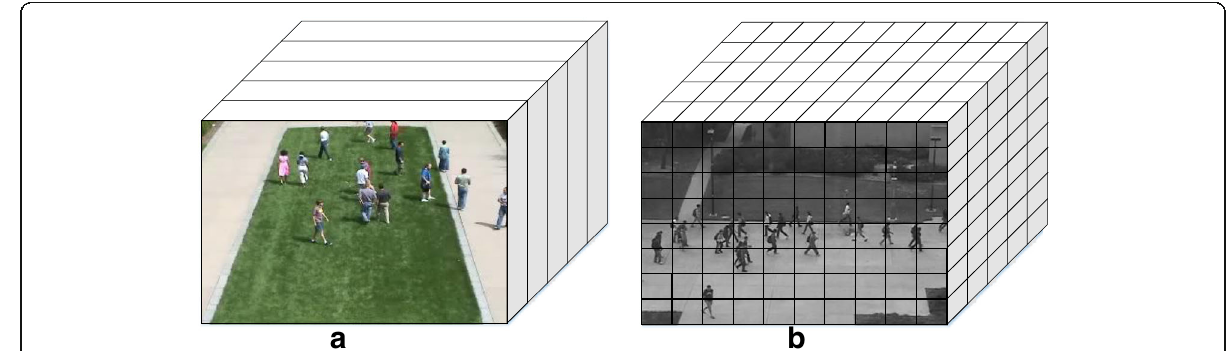
Fig. 3 Illustration of the division of a video sequence. The sequence is divided into ( a ) a set of temporal clips for global AED and ( b ) a set of spatio-temporal cuboids for local